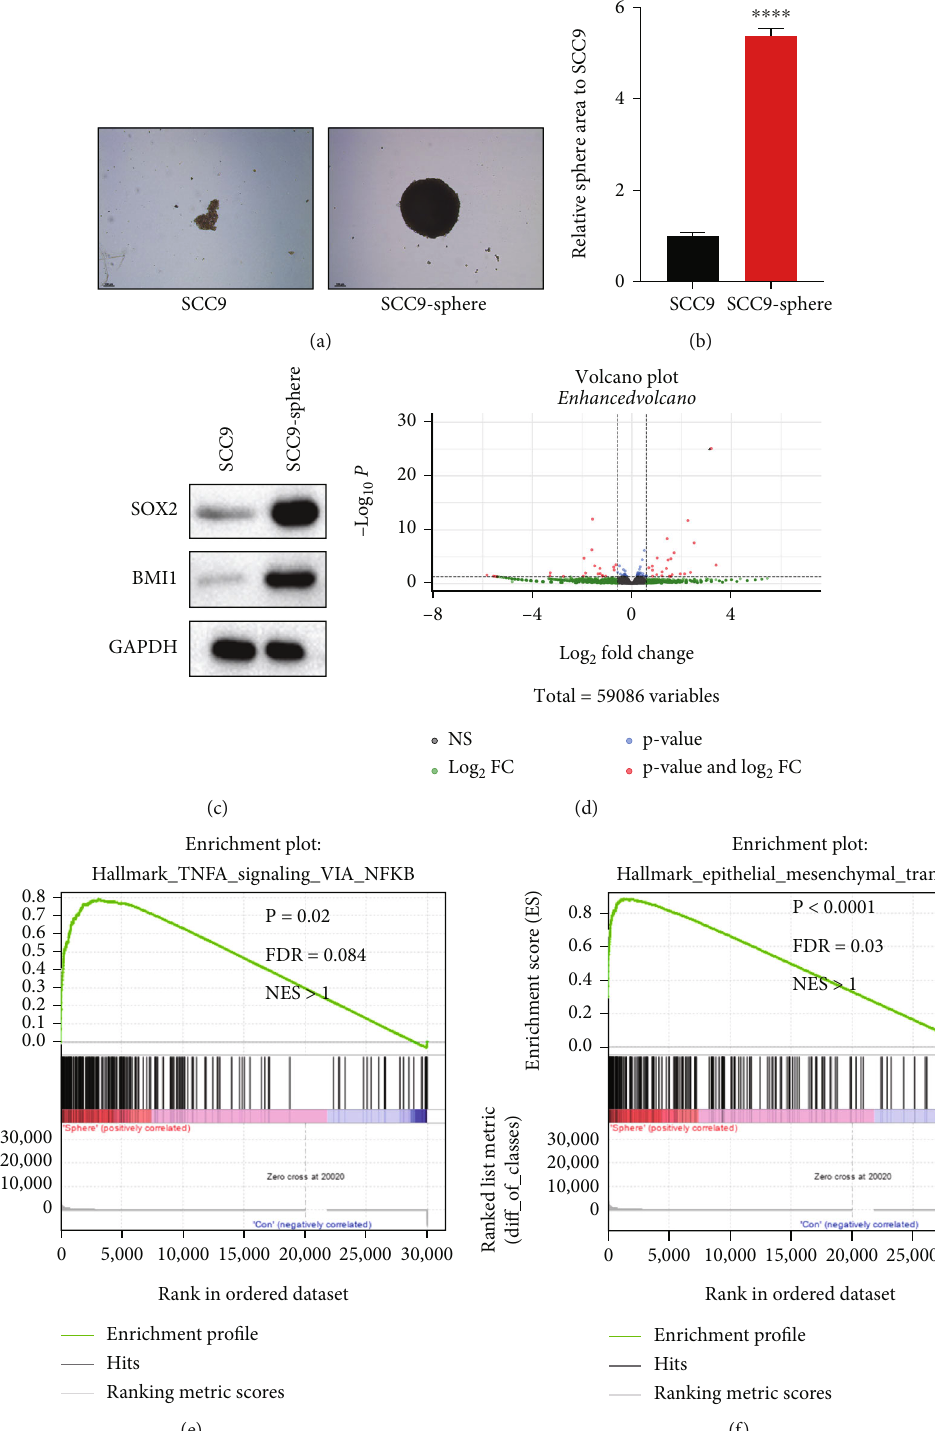
Figure 1: SCC9-sphere exhibits in fl ated CSC-like properties. (a) The comparison of sphere formation ability between SCC9-sphere and SCC9 cell line. Scale bar, 100 μ m. (b) Bar graph showed SCC9-sphere enhanced the sphere formation ability compare with the SCC9 cell line. (c) SOX2 and BMI1 protein levels in two groups. (d) Volcano plot of di ff erentially expressed genes from RNA sequencing results. (e, f) GSEA comparing the SCC9-sphere group with the SCC9 cell line group in TNFA and EMT signaling pathway. Nominal p values, false discovery rate (FDR), and normalized enrichment score (NES) were